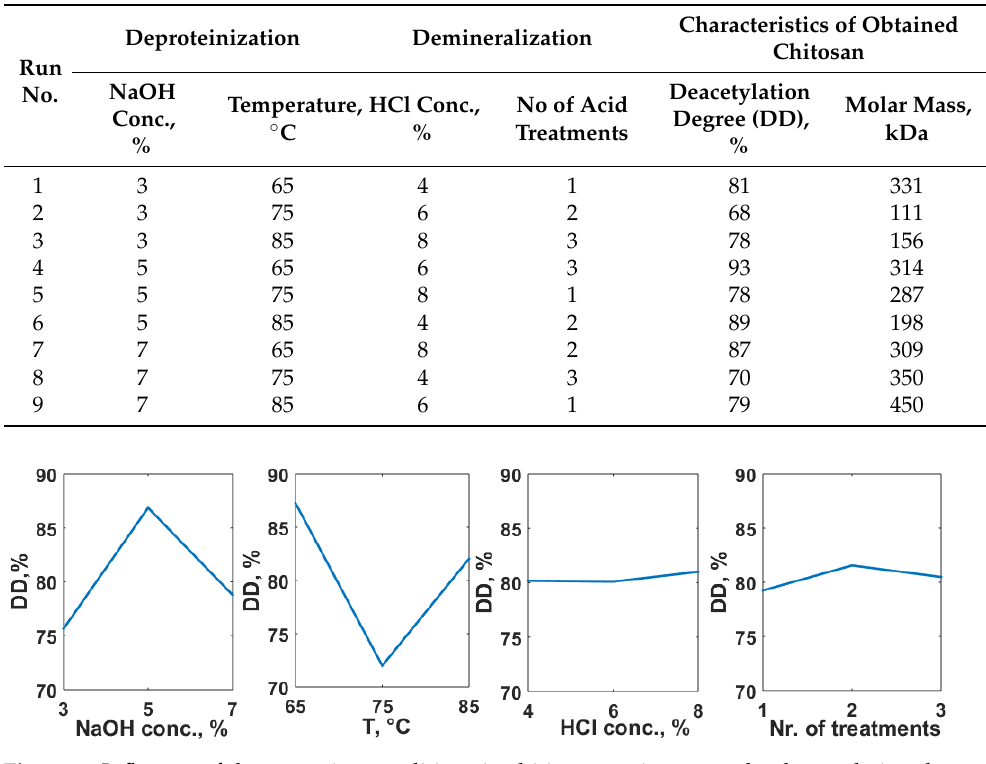
Figure 2. Influence of the operating conditions in chitin extraction upon the deacetylation degree of chitosan.